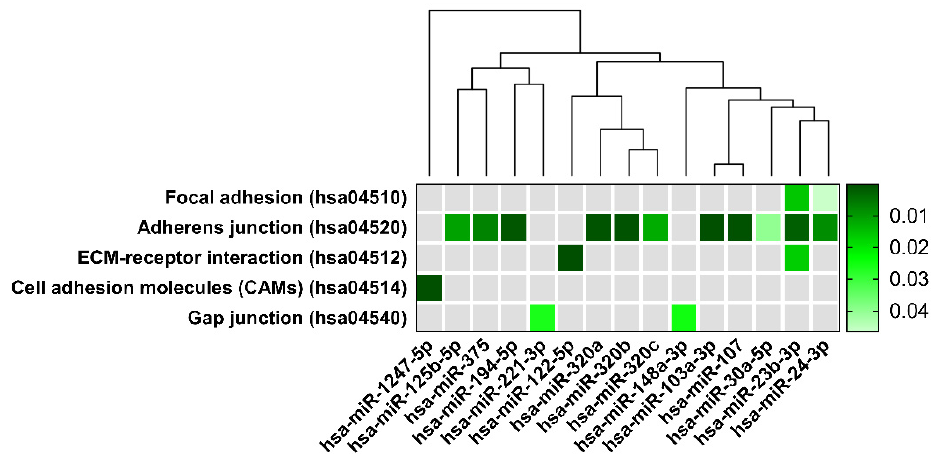
Figure 6. Heatmap of selected pathways predicted by DIANA-miRPath miRNA with hierarchical cluster dendrogram achieved by the linkage clustering method via TarBase. KEGG pathways classification analysis of differentially expressed miRNAs is presented on the y-axis and miRNAs on the x-axis. The color intensity represents the p-value with dark green as the most significant predicted miRNA-pathway interactions ( p < 0.05 in Fisher’s Exact Test).